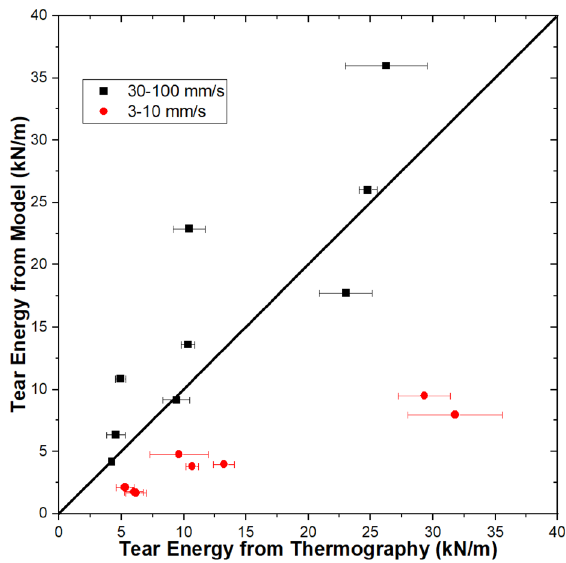
Figure 8. Tear energy from the base model plotted as a function of tear energy calculated from thermography data. Results are from Ref. 17 . Error bars represent standard deviation.